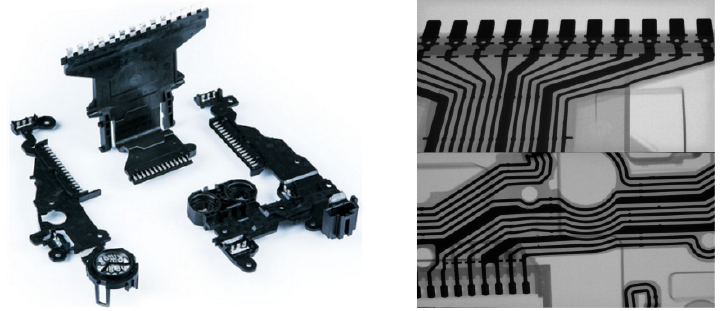
Figure 1. Lead frame over-molded ( left ) and its DR image under X-ray ( right ).